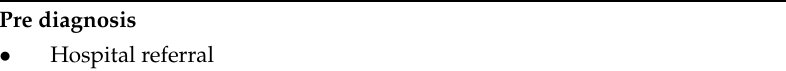
Table A2. Care pathway for non-metastatic breast cancer